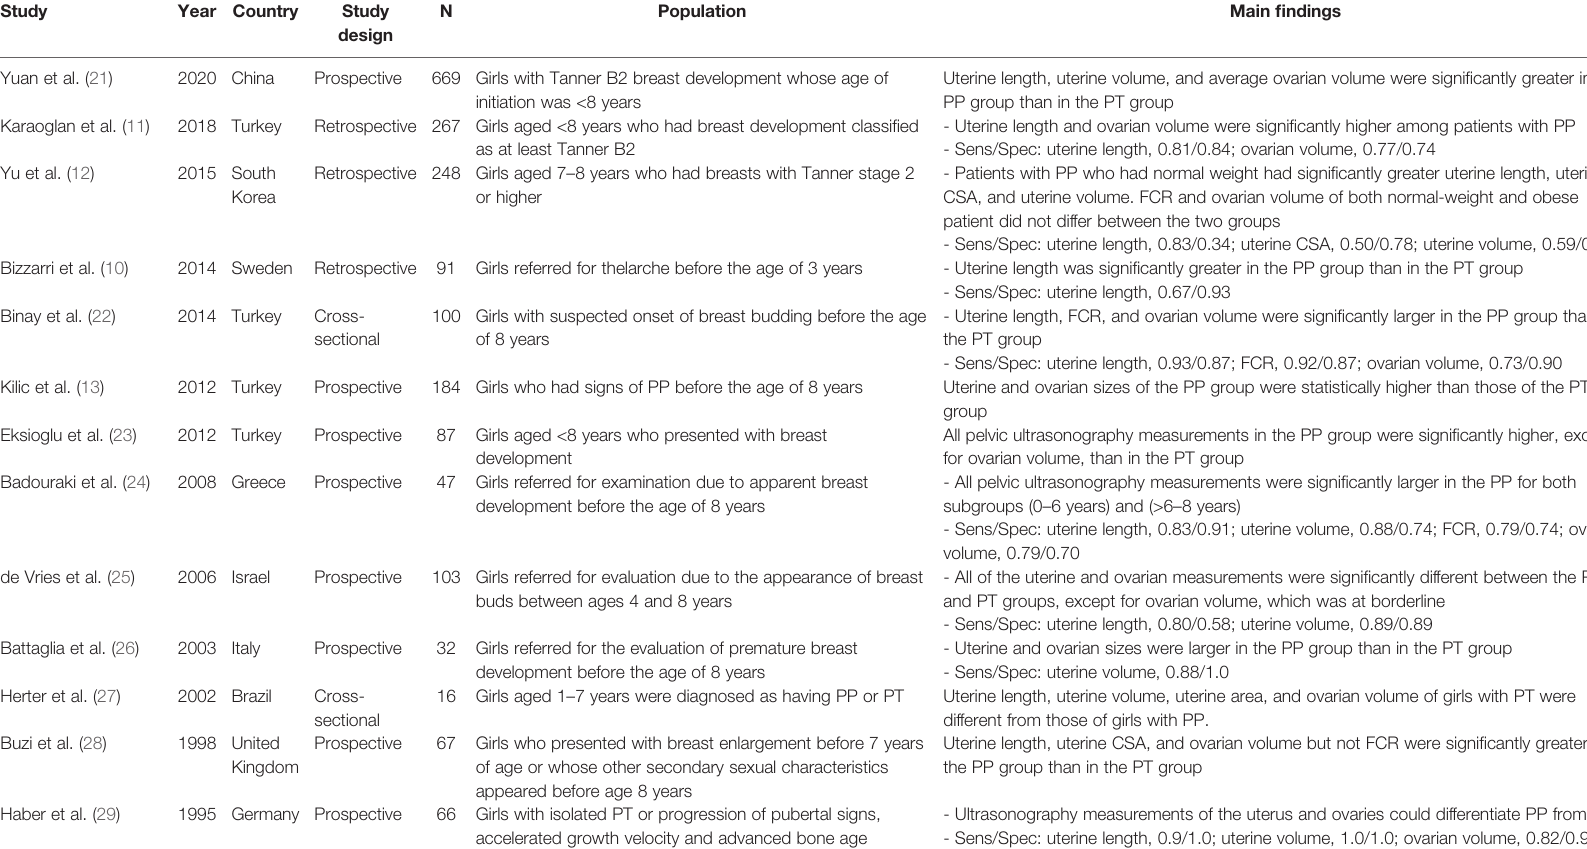
TABLE 1 | Characteristics of the included studies (systematic